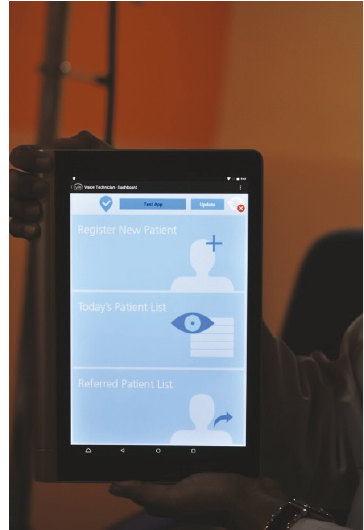
Figure 10: eyeSmart app on the tablet.